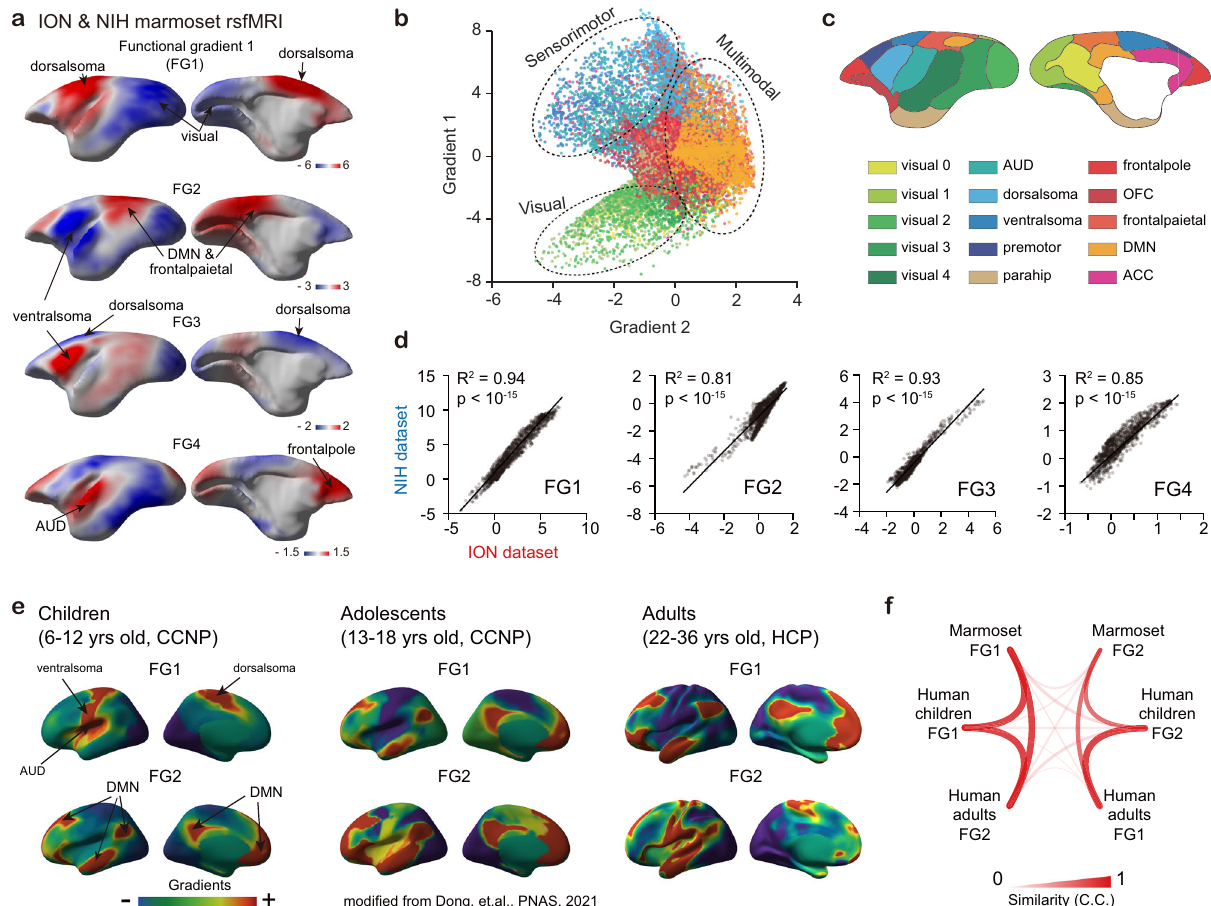
Fig. 1 | Large scale functional connectivity gradients in marmoset and human. a First four gradients of marmoset function connectivity. FG, functional gradient. b Scatter plot of marmoset fi rst two function gradients. Each dot represented a cortical voxel, colored by the Fig. c . Gradient 1, “ visual-to-sensorimotor ” intrinsic dimension;Gradient 2, “ multimodal-to-unimodal ” intrinsicdimension. c Marmoset brainnetworkswereparceledbasedontheMBMv4-Network 22 .Theabbreviationof marmoset networks was summarized in Supplementary Table 1. d Cross-dataset